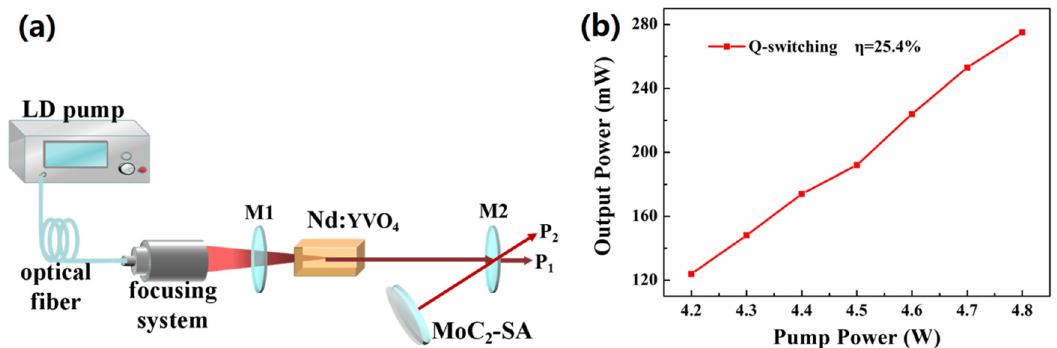
Figure 3. ( a ) Schematic depicting the Q-switched Nd:YAG solid-state lasers and ( b ) the relationship between average output power and input pump power.